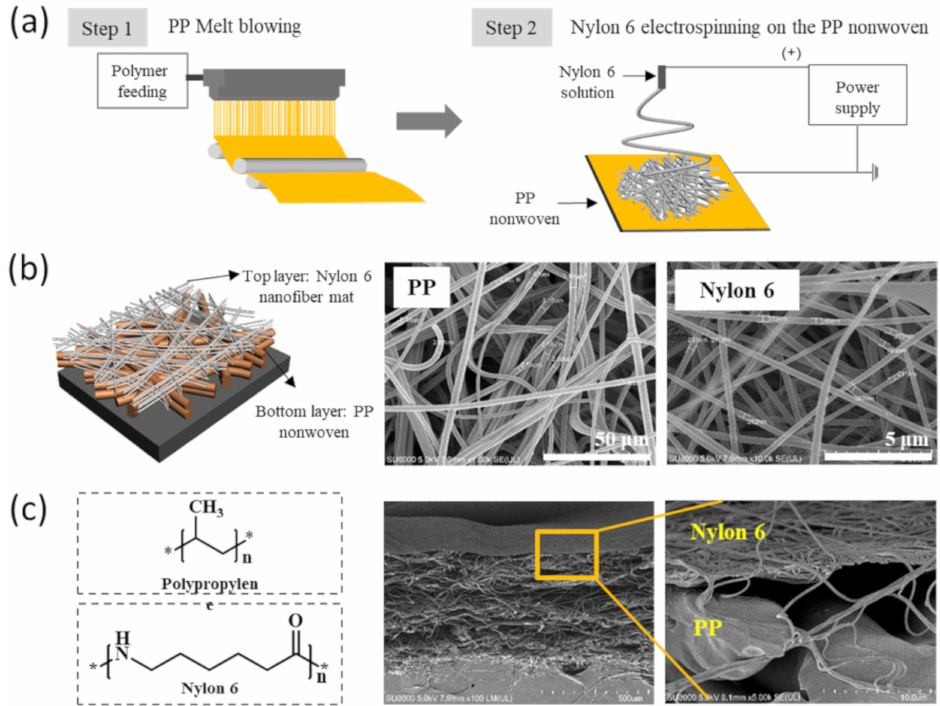
Figure 1. ( a ) Schematic diagram of the fabrication process and surface morphology of the nonwoven polypropylene (PP) and nylon 6 nanofiber mat, ( b ) the fabricated nano- and micro-fiber-based triboelectric nanogenerators (NMF-TENGs) structure with field emission scanning electron microscopy (FE-SEM), ( c ) chemical structures of the PP and nylon 6, and the cross-sectional FE-SEM images of the nonwoven PP layered with the nylon 6 nanofiber